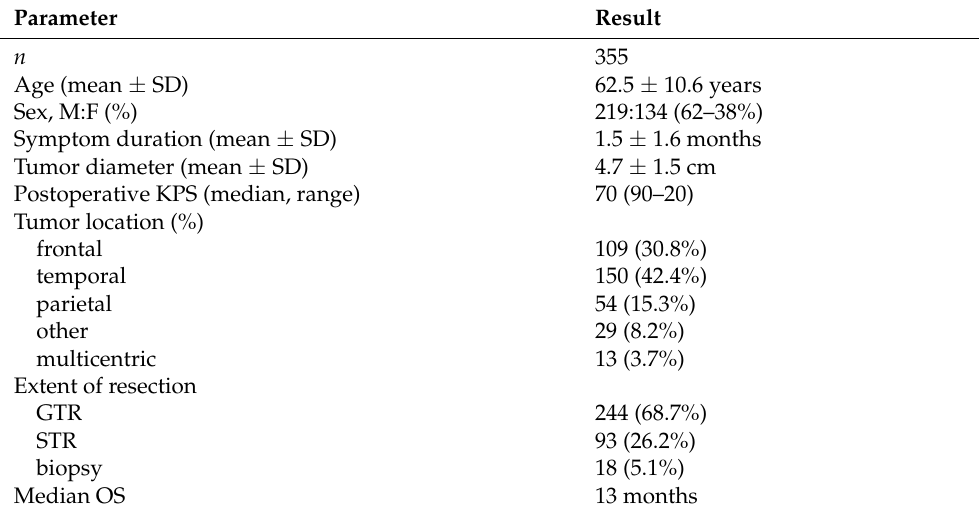
Table 1. Clinical characteristics of enrolled patients.